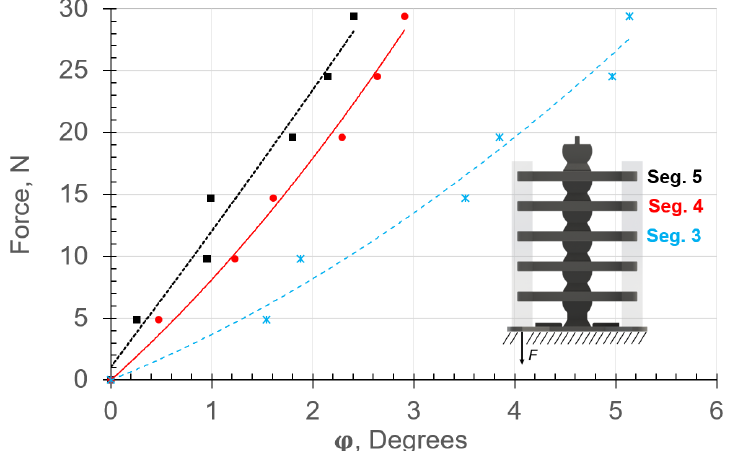
Figure 14. Force–response results for vertical loading obtained by applying force at the end of the left-side fibers. Experimental and analytical (from (9)) results are shown in markers and lines, respectively. Note the nonlinear bending behavior due to contraction of the soft material on one side and stretch on the other.